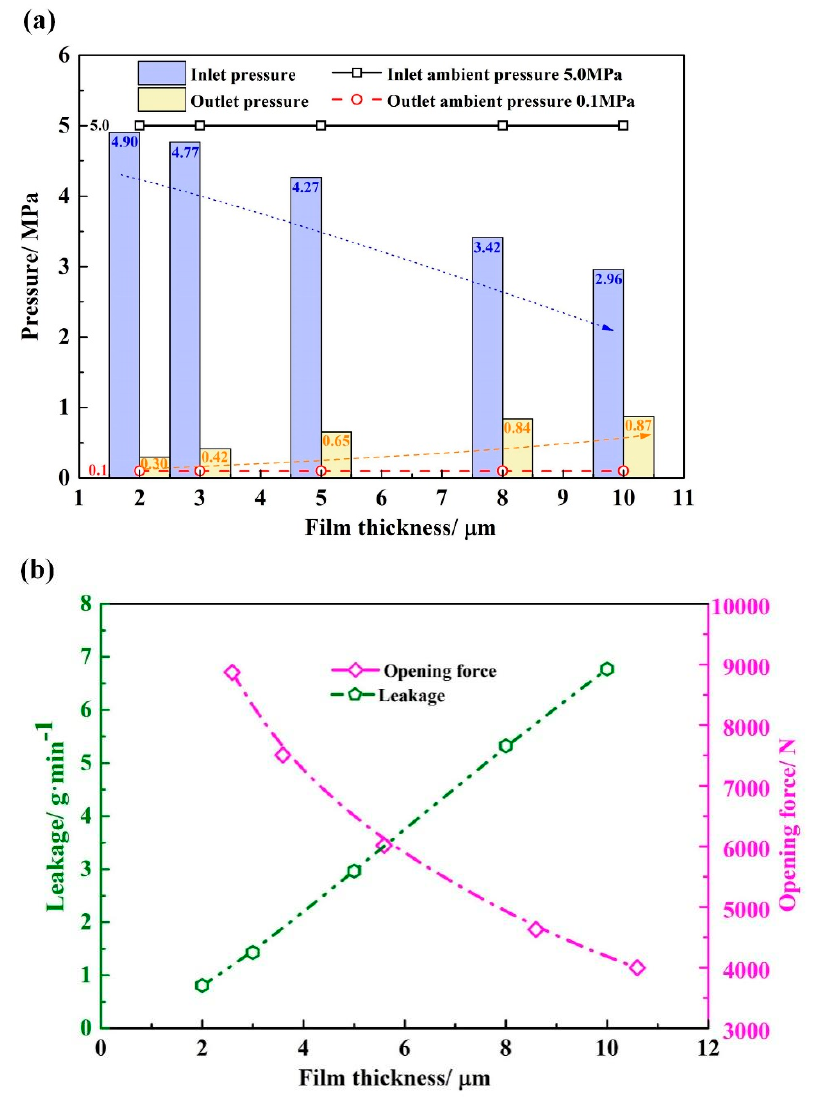
Figure 12. Relationship between the sealing performance and the basic film thickness. ( a ) Pressure boundaries between the seal rings; ( b ) Opening force and leakage. ( P in = 5.0 MPa, P out = 0.1 MPa, T in = 200 K, T out = 350 K, n = 50,000 rpm).